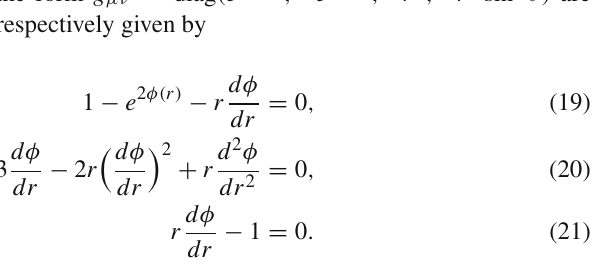
the form g μν = diag ( e 2 φ( r ) , − e 2 λ( r ) , − r 2 , − r 2 sin 2 θ) are